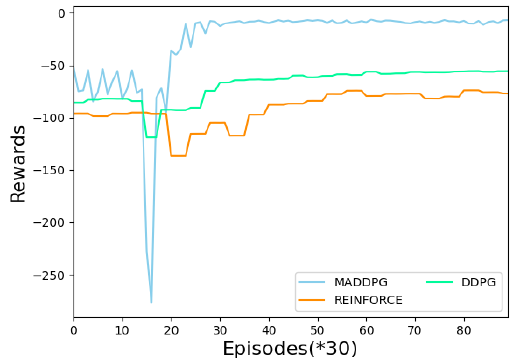
Figure 3. Rewards versus episodes under different RL algorithms.